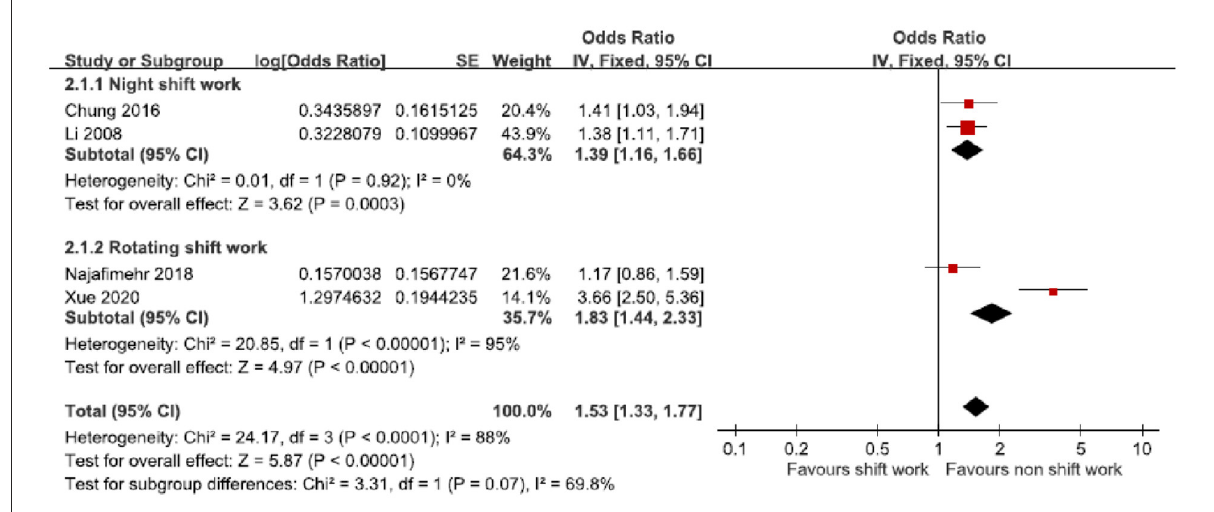
FIGURE4 Subgroup analysis of odds ratios of possible GERD based on the style of shift work.